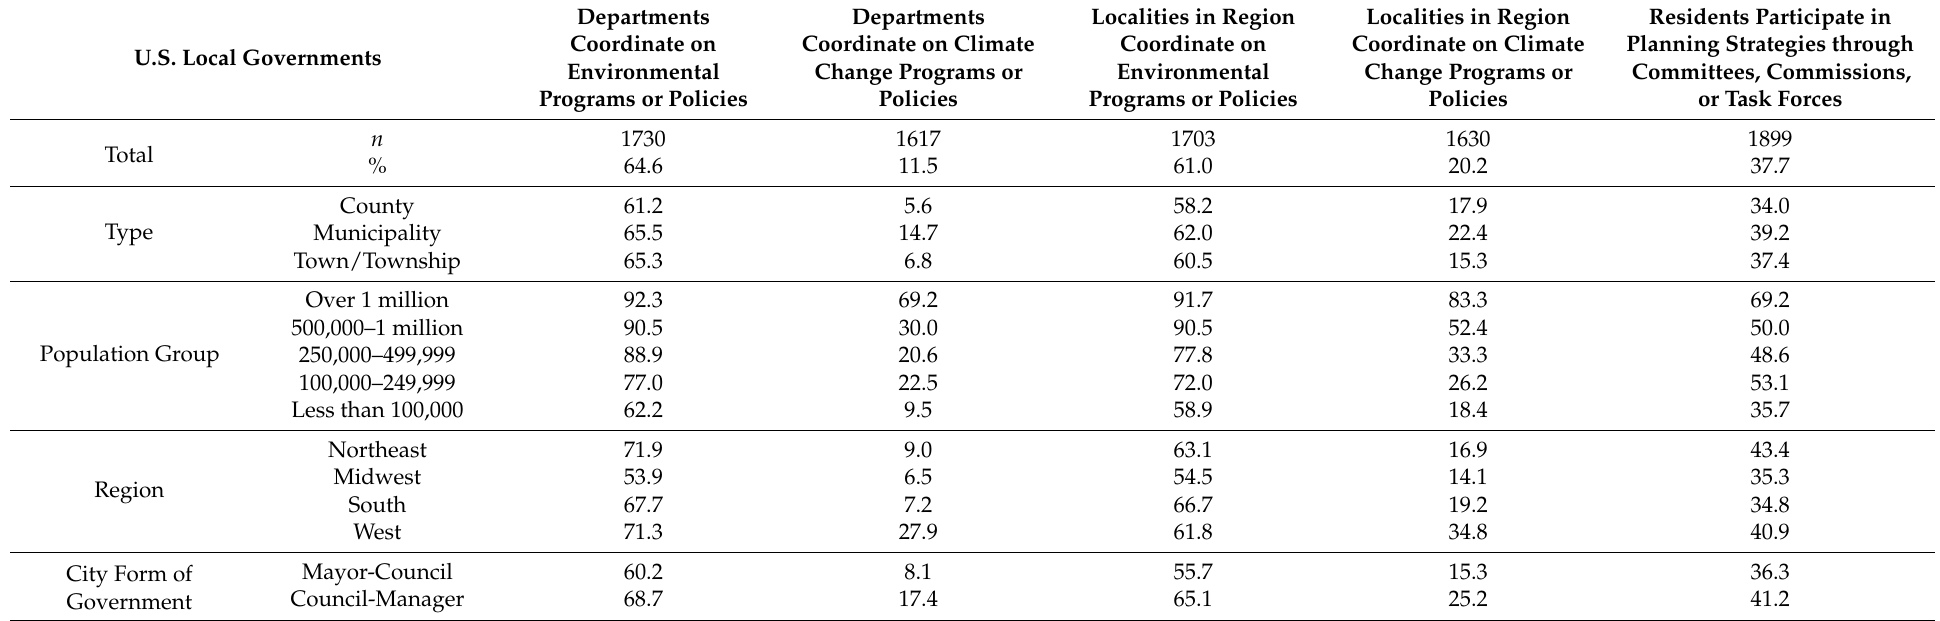
Table 5. U.S. Local Government Collaboration and Capacity Regarding Environmental and Sustainability Programs or Policies, 2015. Percent responding yes. Source: International City/County Management Association, Local Government Sustainability Practices Survey